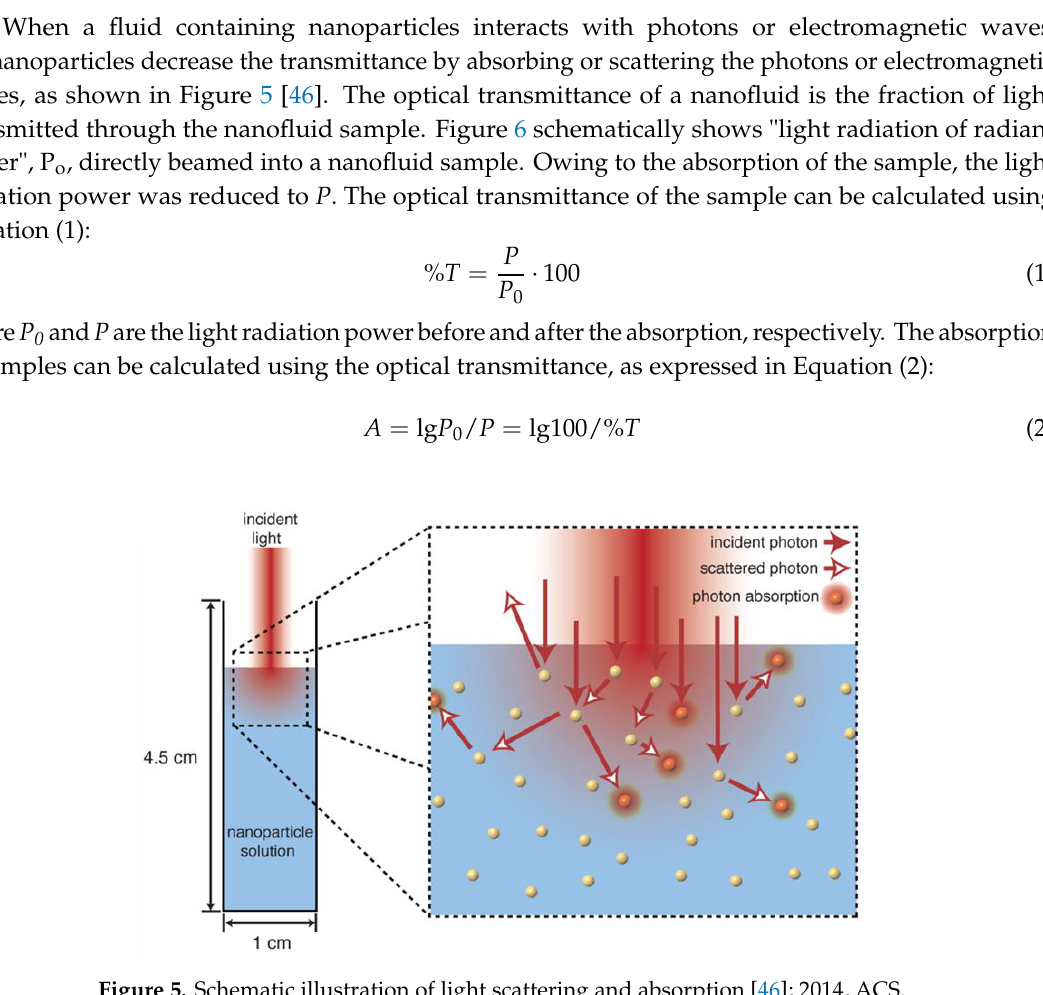
Figure 4. The change of optical absorption of plasmonic metals with the influence of structural tuning [3]; 2018, RCS.